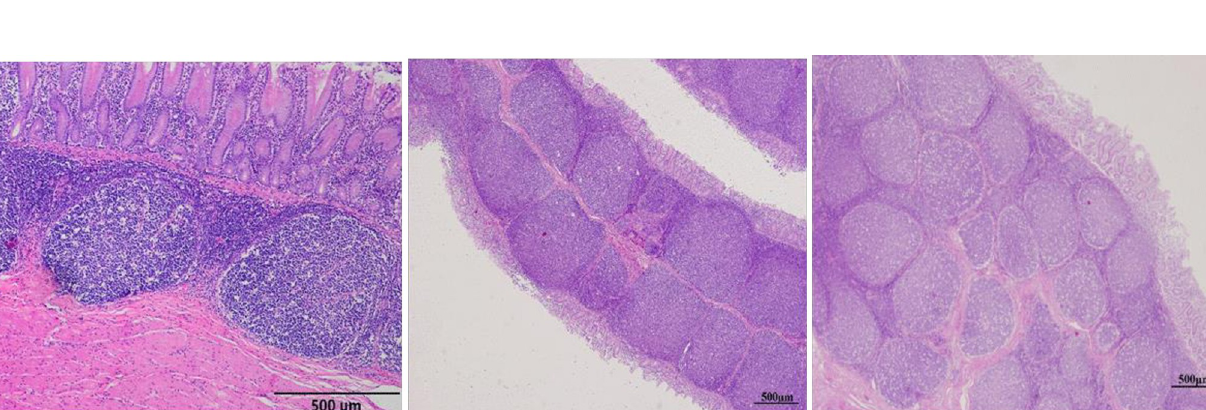
PLOS ONE | https://doi.org/10.1371/journal.pone.0279417 March 22,